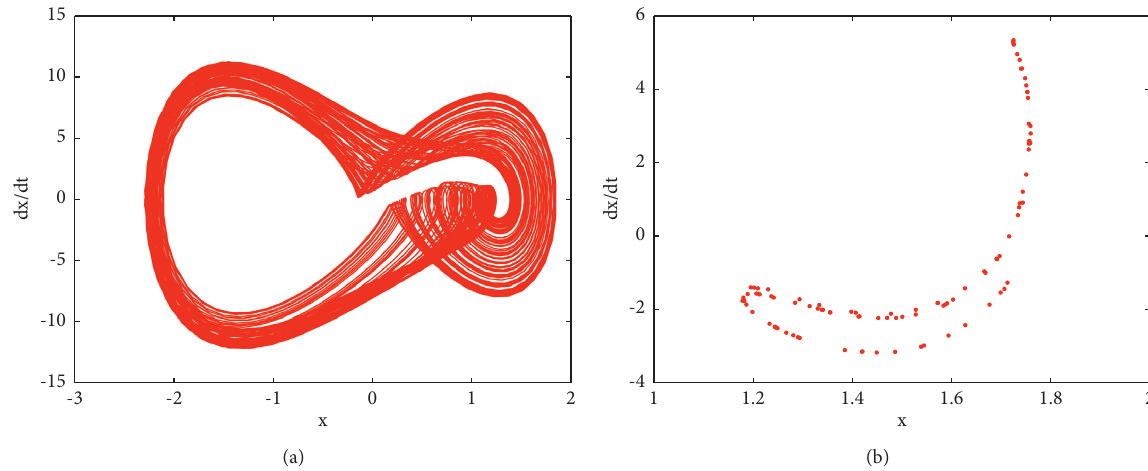
Figure 10: Phase portrait, time history, and Poincar´e cross section diagram of the system at F � 53 and τ � 1.2. (a) Phase portrait. (b)